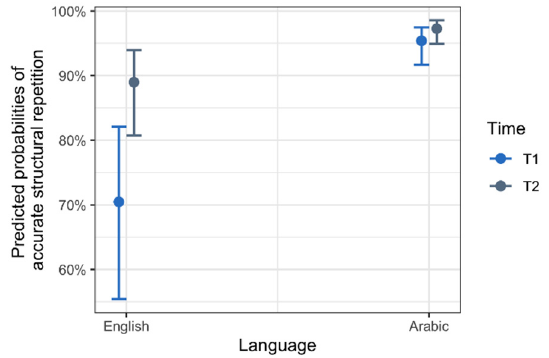
Figure 2. Marginal effects of the Language*Time interaction in the logistic mixed-effects model comparing performance in the two languages at the two times. The point indicates the predicted average probability of a morphosyntactic structure being repeated accurately according to Language and Time. The whiskers indicate the 95% confidence interval.